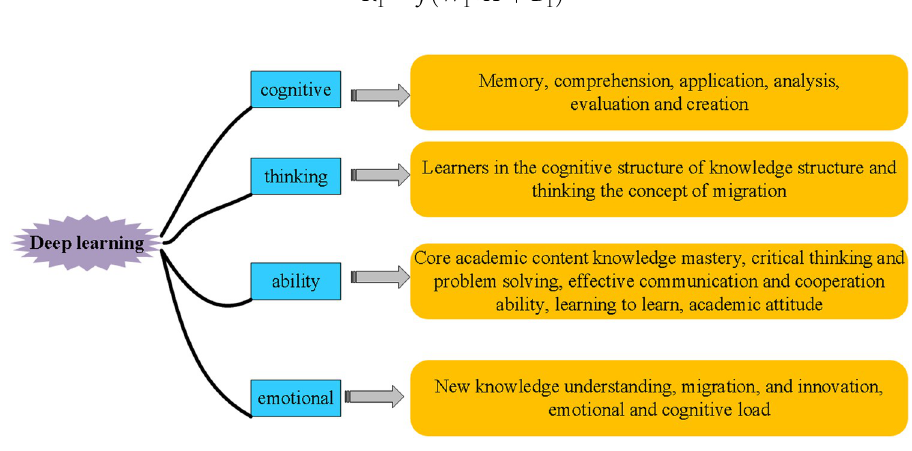
Fig 2. Definition to deep